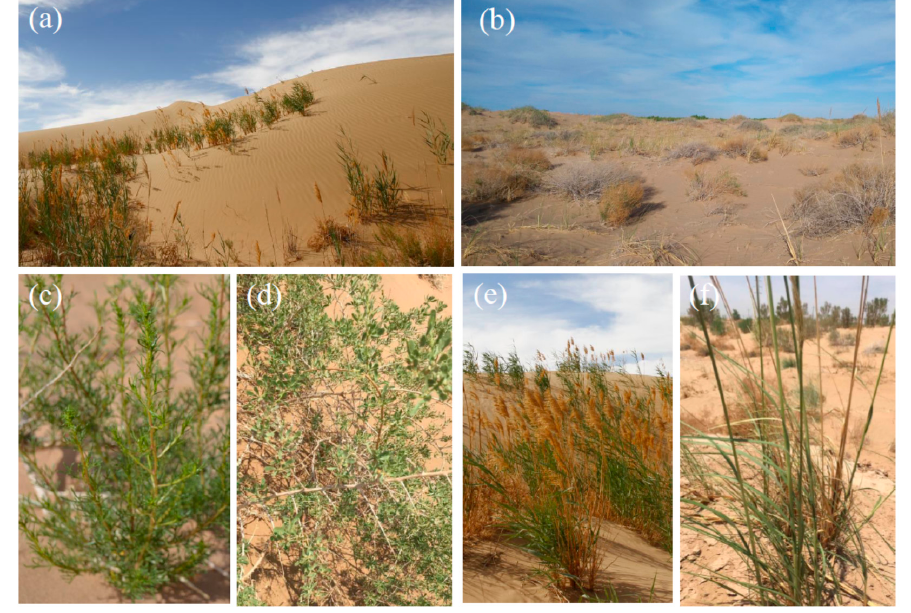
Figure 2. Sampling sites and vegetation in the Ulan Buh Desert (Gobi Desert, Inner Mongolia). ( a ) Site A; ( b ) Site B; ( c ) Artemisia sphaerocephala ; ( d ) Nitraria tangutorum ; ( e ); Phragmites australis ; ( f ) Psammochloa villosa .